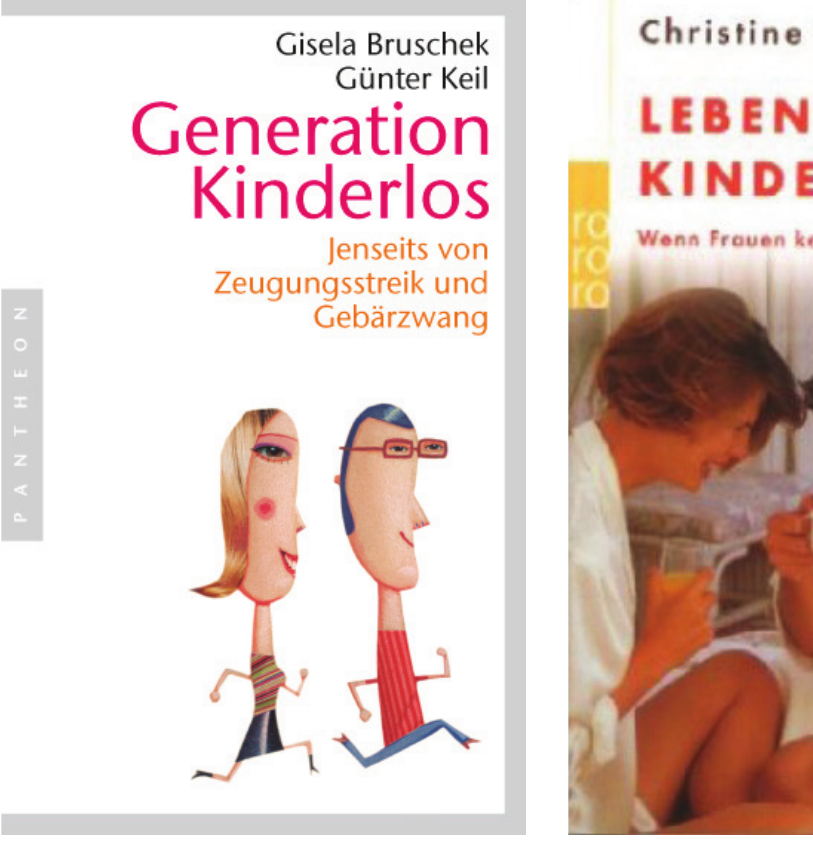
Figure 29. Book cover: Generation Childless: Beyond Birth Strike and Compulsory Motherhood , published 2008. Used by permission of Jorge Schmidt and corbis images